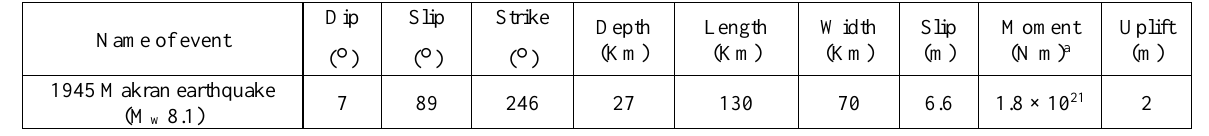
Table 1. Seismic parameters of the Makran 1945 tsunami (Heidarzadeh et al., 2008)